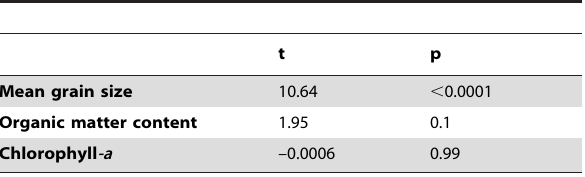
Table 4. Student’s t-test of environmental variables between the two field sampling stations (n